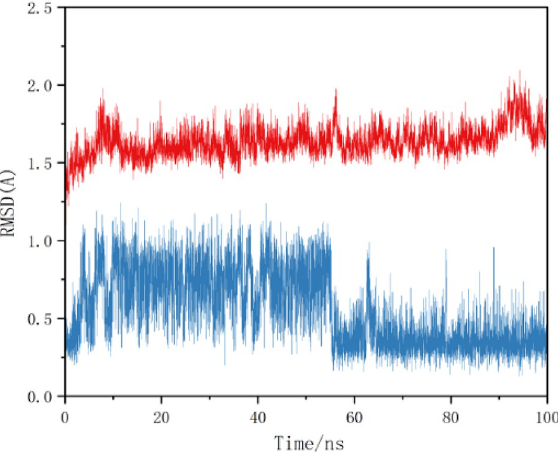
Figure 5. Differences in the root mean square deviation (RMSD) of the plural over time (blue polygonal line means glabrone and S-protein, red polygonal line means licoisoflavone B and